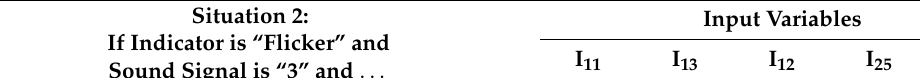
Table 5. Modeling results on Situation